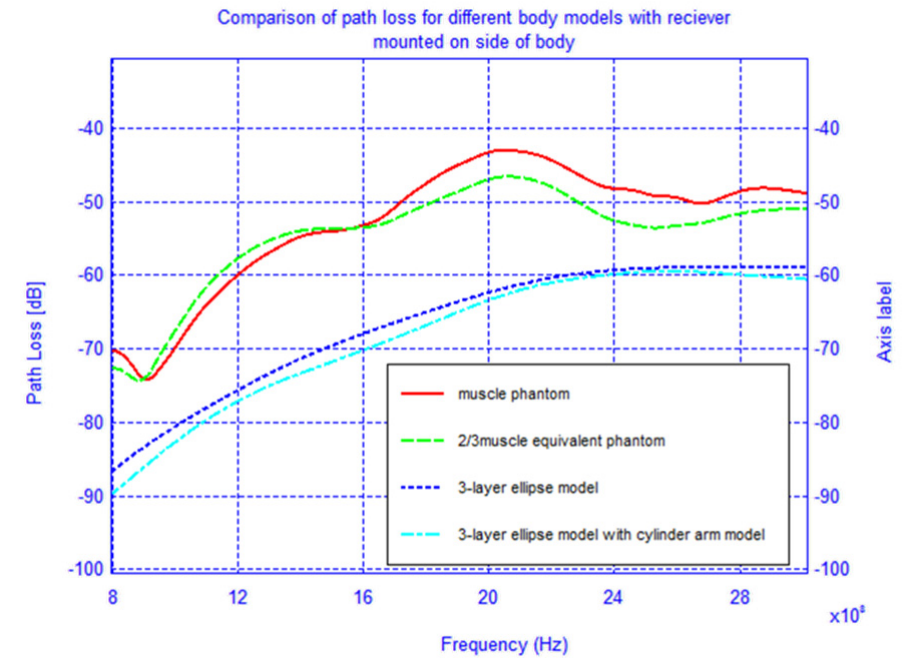
Figure 22. Comparison of the path loss for different phantom models with receiving antenna on the shoulder side of the body and transmitting antenna at the